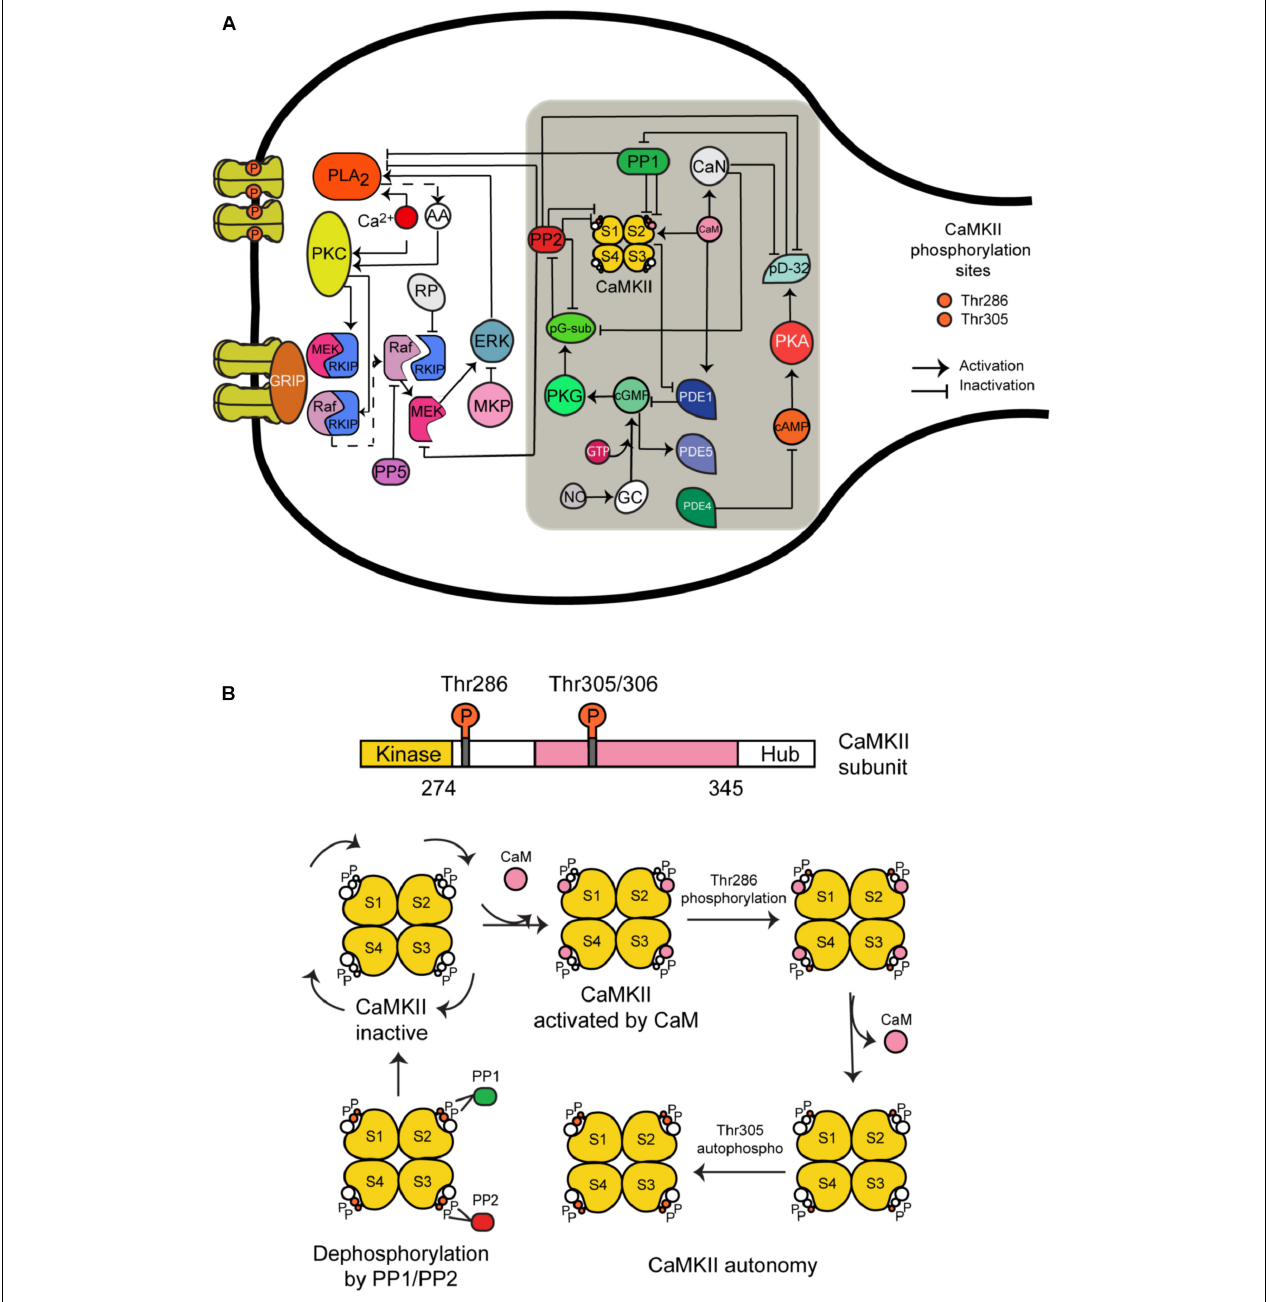
FIGURE 1 | The long-term depression signaling pathway including the molecular network regulating CaMKII activity at postsynaptic density. (A) The molecules we have added to this signaling pathway are CaMKII (four subunits model); calmodulin (CaM), calcineurin (CaN); phosphodiesterases PDE1, PDE4, and PDE5; phosphatases PP1 and PP2A; protein kinase A (PKA) and G (PKG); cAMP and cGMP; NO; and DARP32. This figure was based on the previous model of LTD and extended with CaMKII molecular interactions (gray box). (B) All possible states of CaMKII activation.